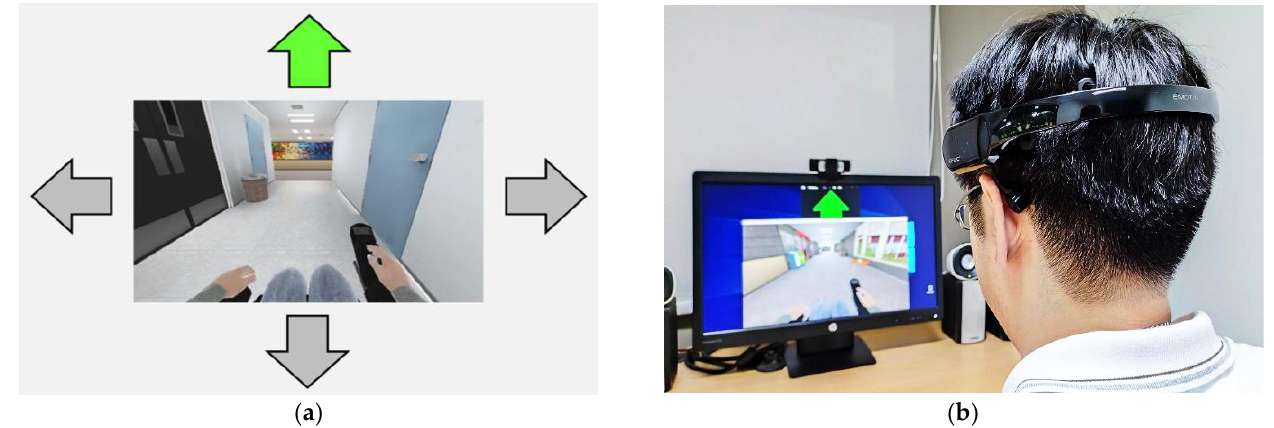
Figure 8. ( a ) Graphic user interface with simulated power wheelchair; ( b ) the example scenario of the simulated wheelchair control during the experiment.